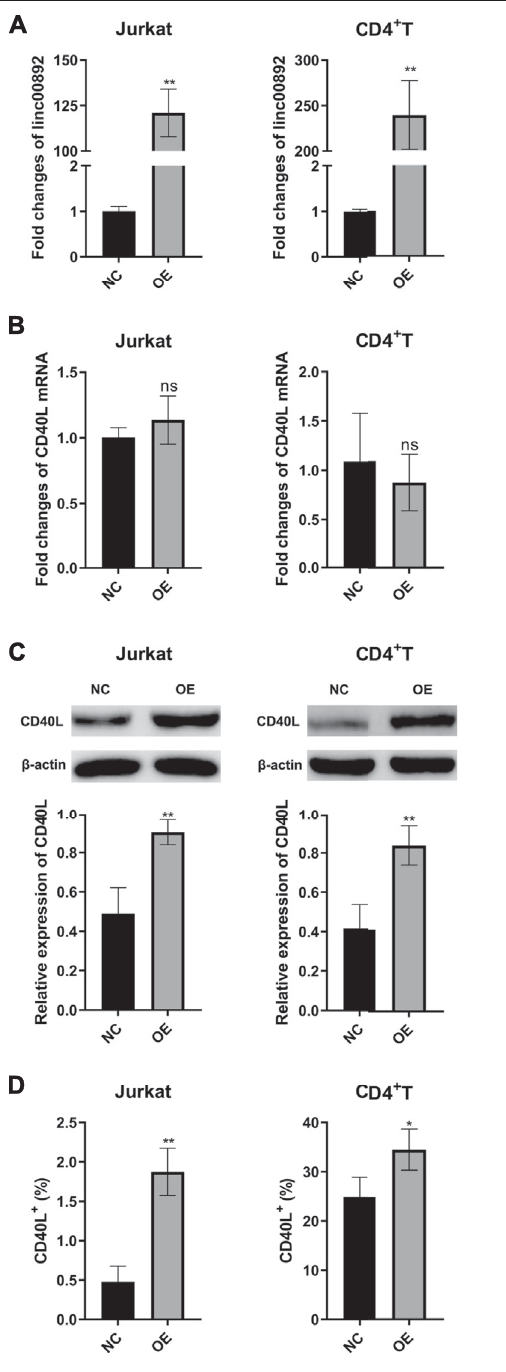
FIGURE2| LincRNA00892enhancedCD40LexpressioninJurkatandprimaryCD4 + Tcells. (A) , (B) :TheexpressionoflincRNA00892 (A) andCD40L (B) inJurkat and primary CD4 + T cells transfected with lentiviruses with control vector or vector containing the lincRNA00892 fragment was de fi ned by qRT-PCR. (C) The protein levels of CD40L in the negative control and lincRNA00892 overexpression group in both Jurkat and primary CD4 + T cells were con fi rmed by western blotting. (D) The levelofCD40LexpressedonthesurfaceofbothJurkatandprimaryCD4 + TcellsinbothnegativecontrolandlincRNA00892overexpressiongroupwereperformed by fl ow cytometry. NC (cid:1) negative control, OE (cid:1) overexpression, NS (cid:1) no statistical difference. ** p < 0.01, * p < 0.05. The results are expressed as mean ± standard deviation. Student ’ s t-test was used for comparison of two groups.